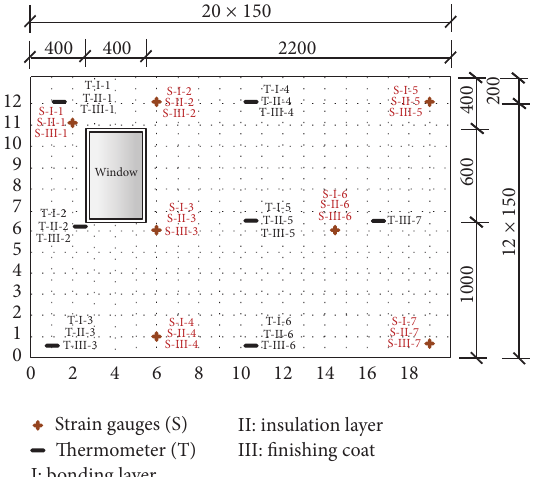
Figure 2: Schematic graph of measuring points (mm).